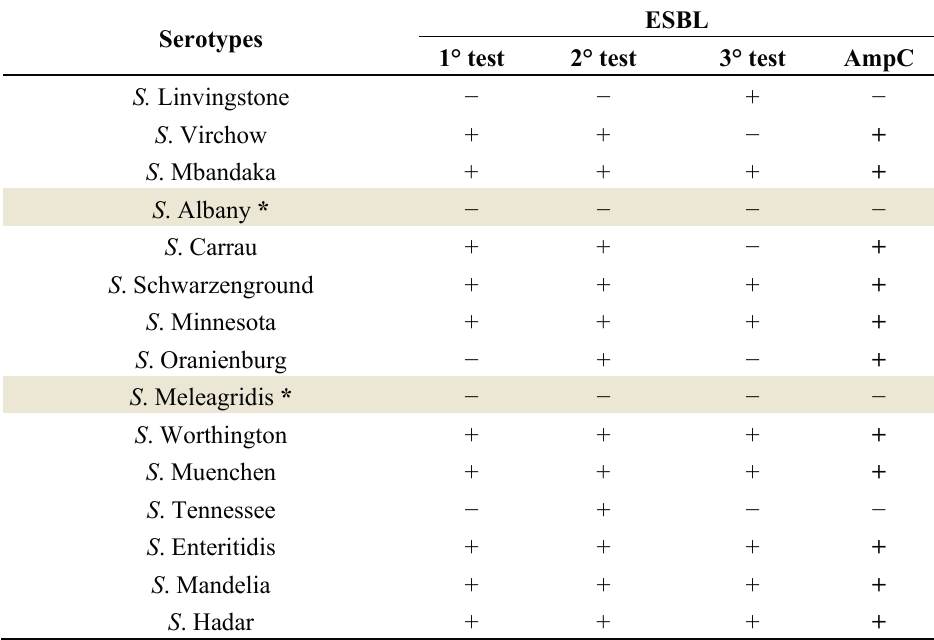
Table 2 . Results for extended spectrum β -lactamase-producing and AmpC β -lactamase- producing Salmonella enterica subsp. enterica (Serotypes) after three